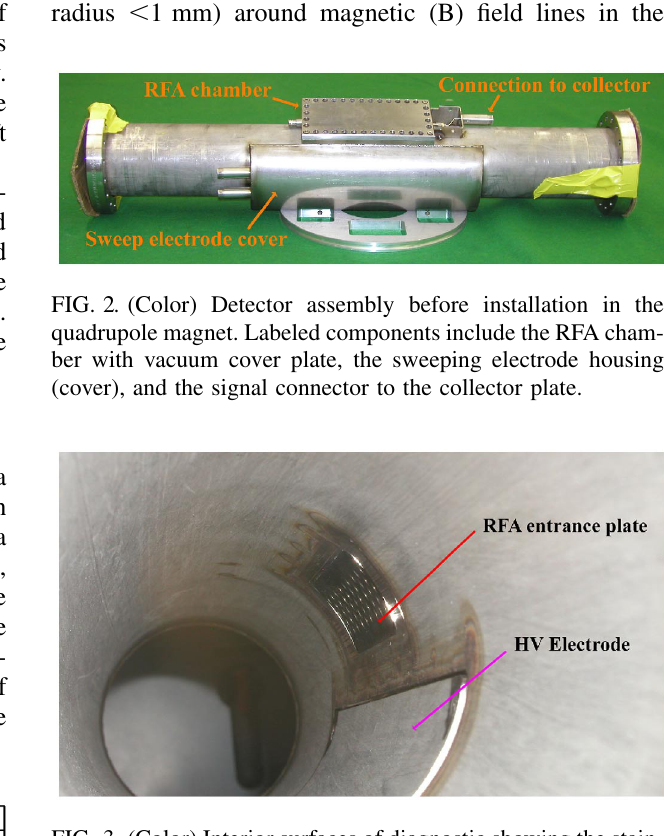
FIG. 3. (Color) Interior surfaces of diagnostic showing the stain- less steel RFA entrance plate and the HV sweeping